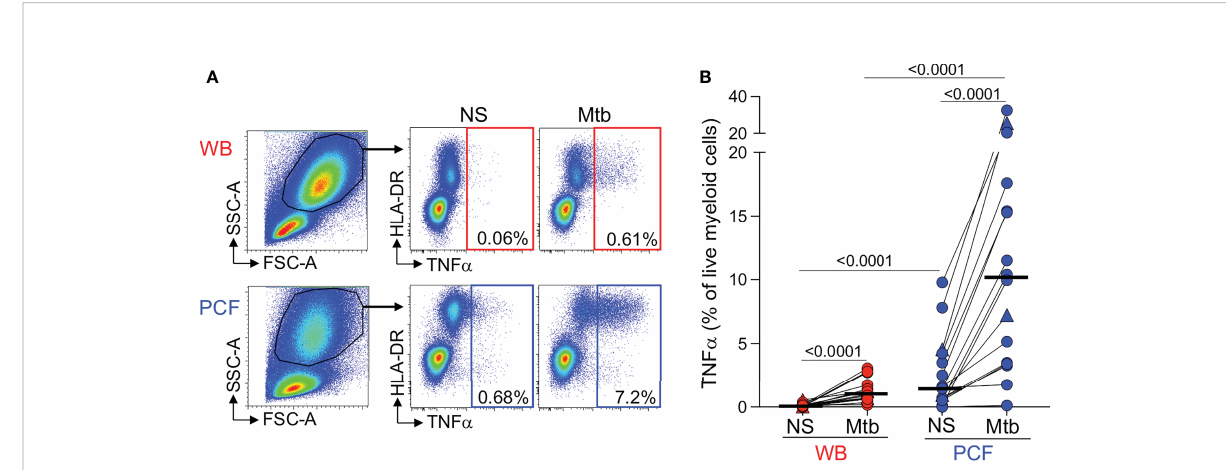
FIGURE 2 Comparison of TNF a production by granulocytes/myeloid cells in response to Mtb stimulation between whole blood and PCF. (A) Representative example of TNF a -producing cells in responses to Mtb antigen stimulation. Granulocytes/myeloid cells were identi fi ed based on their FCS/SSC pro fi le. (B) Frequency of TNF a -producing granulocytes/myeloid cells in unstimulated (Uns) and Mtb-stimulated samples (Mtb) (n = 16). The triangles depict HIV-uninfected participants (n = 2). Bars represent medians. Statistical comparisons were performed using a Wilcoxon rank test for paired samples or a Mann-Whitney test for unpaired